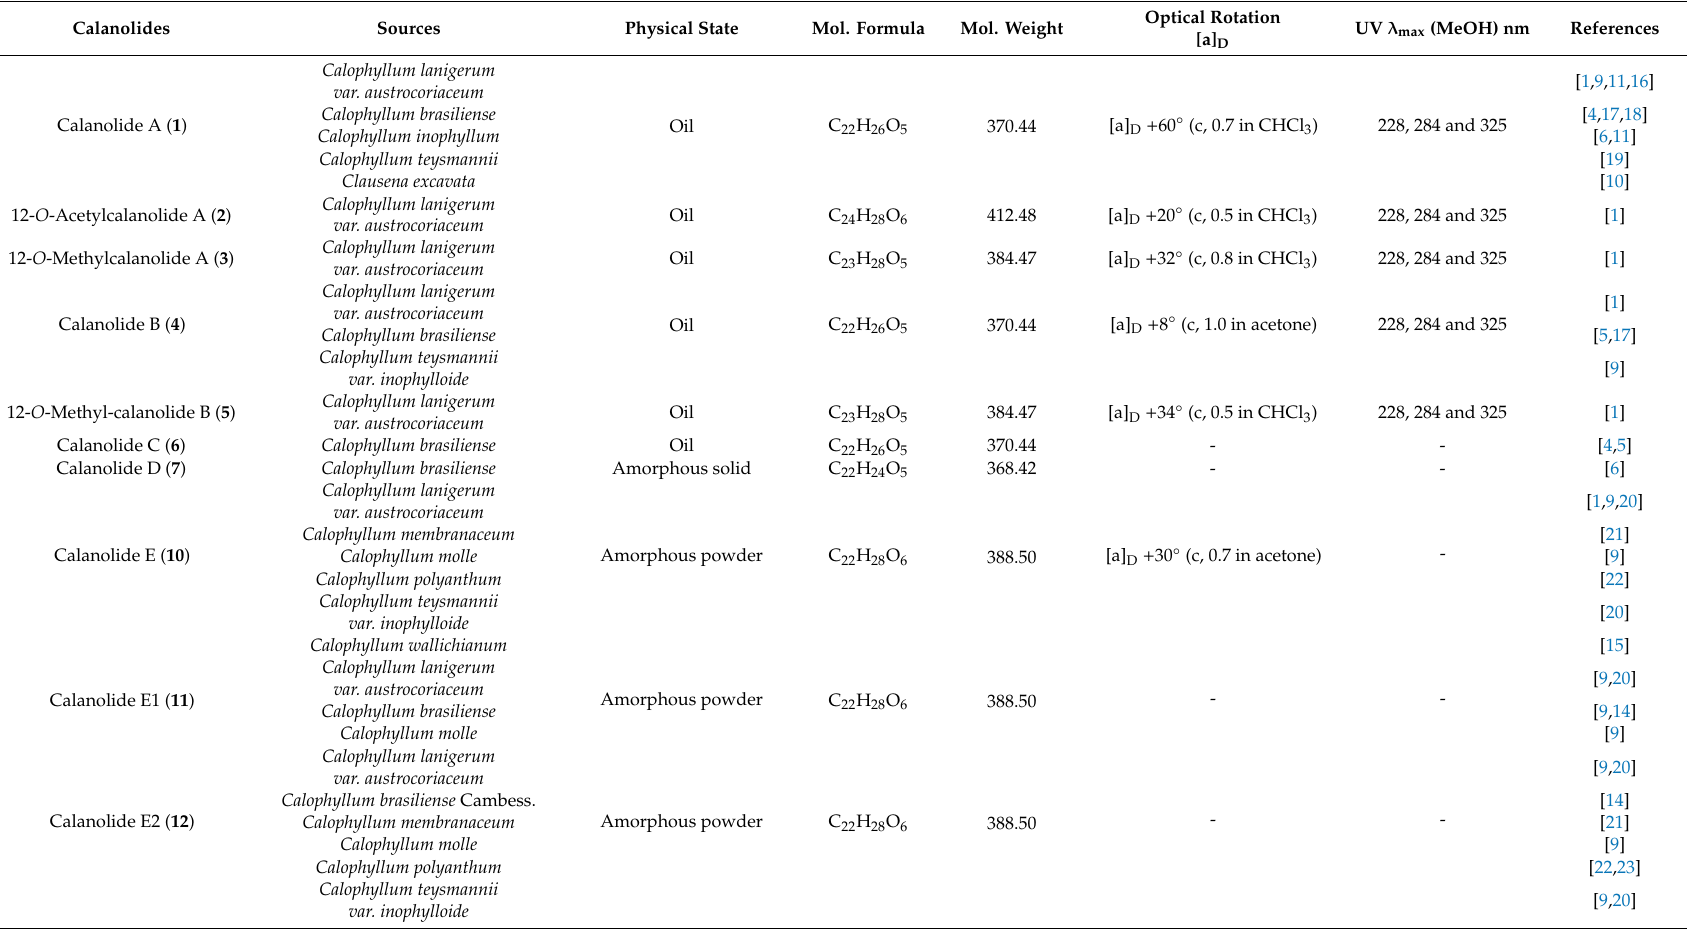
Table 1. Naturally occurring calanolides, their sources and